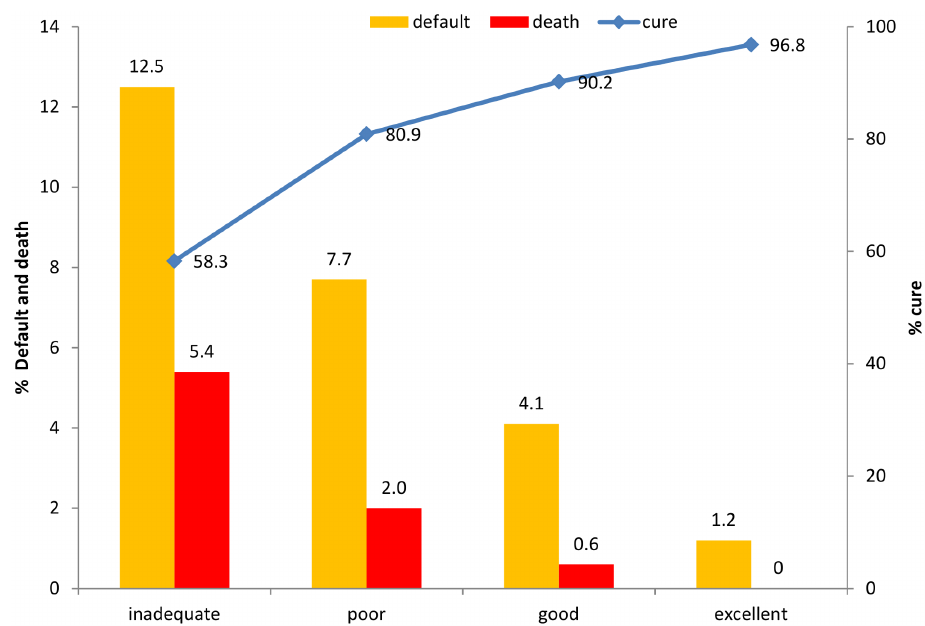
Fig 2. Relationship between treatment outcomes (on the left and right of the axis Y) and classification of the patient ’ s follow-up (on the axis X) for new cases of TB, Brazil 2008 – 2011. Note: On the left of the axis Y you can see the percentage of treatment defaults and death, while on the right of the axis Y you can see the percentage of cure. On the axis X could you see the status of the classification of the patient ’ s follow- up. According our data, rates of cure were lower (blue line), as well as rates of treatment default and death were higher (yellow and red column, respectively) in cases where the patient ’ s follow-up was inadequate. On the other hand, treatment outcome was better in the cases where patient ’ s follow-up were good and excellent (blue